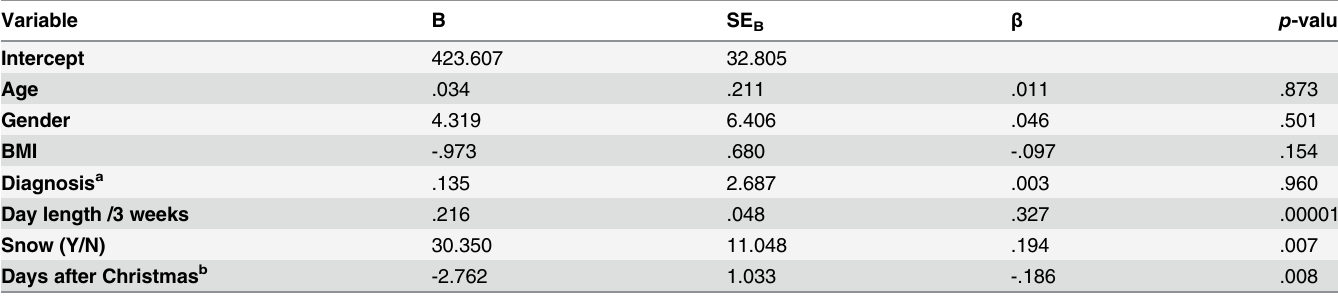
Table 2. Predictors of CSF hcrt-1 level. Summary of Multiple Regression